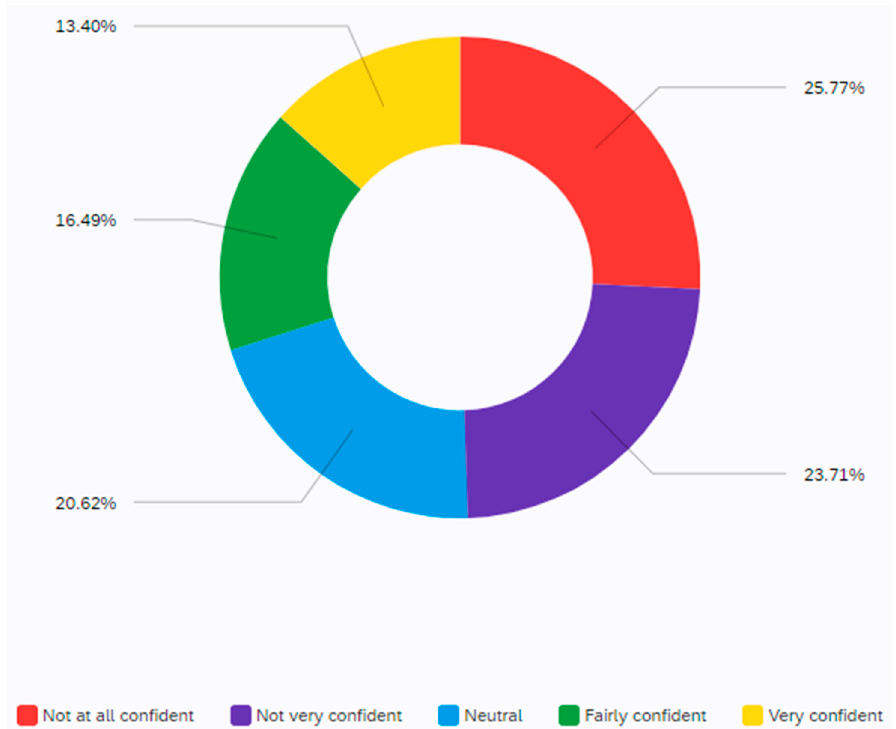
Figure 2. Confidence using the internet (97/100 responded).